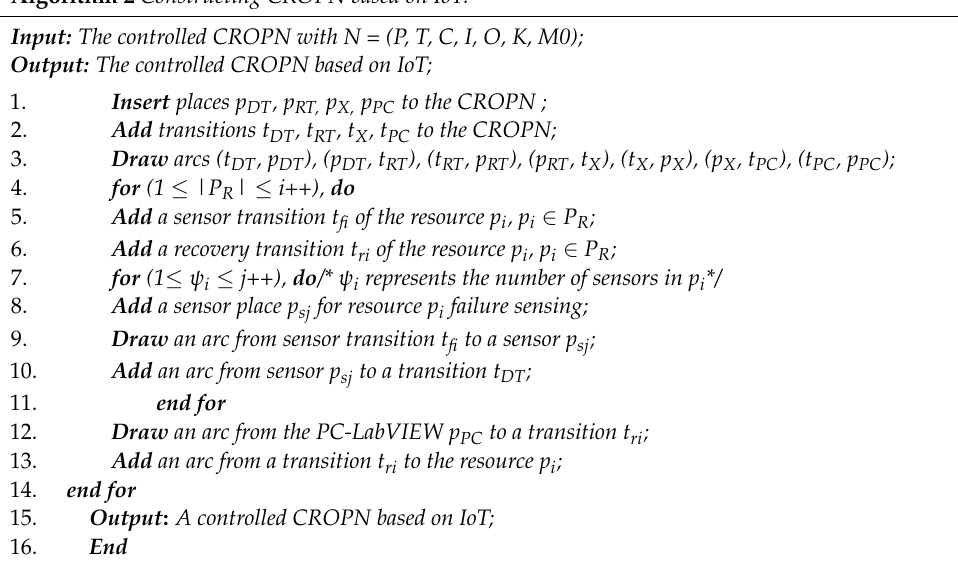
Algorithm 2 Constructing CROPN based on